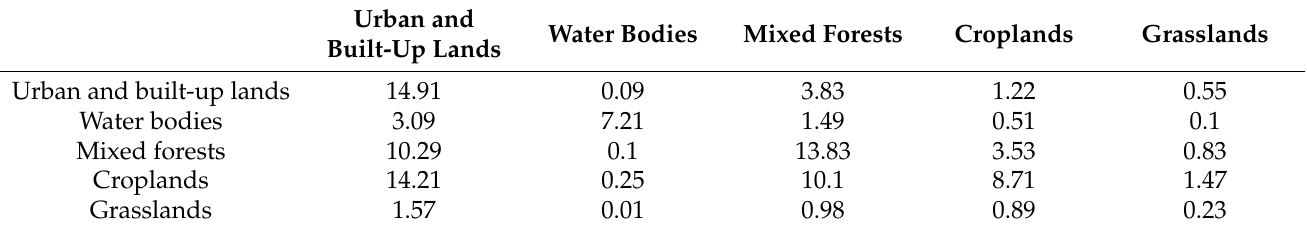
Table A3. The transition matrix of land use/land cover classification for Z01 from 2000 to 2015